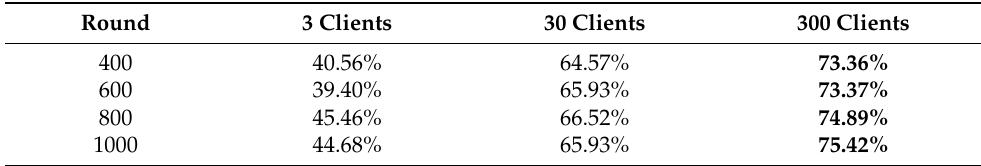
Figure 12. Non-IID with different numbers of clients based on chest X-ray images. Table 8. The summary table of the accuracy of Non-IID with different numbers of clients based on chest X-ray